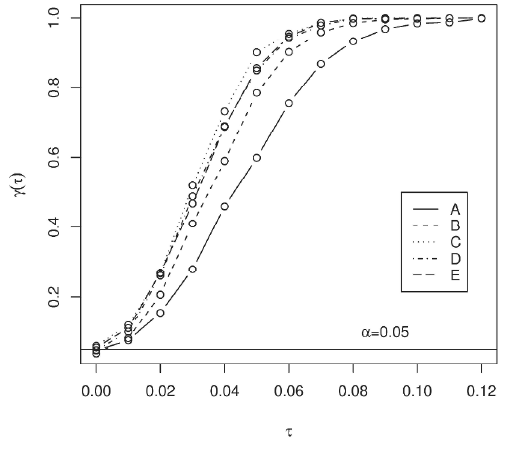
Figure 1 – Power functions for varying sample